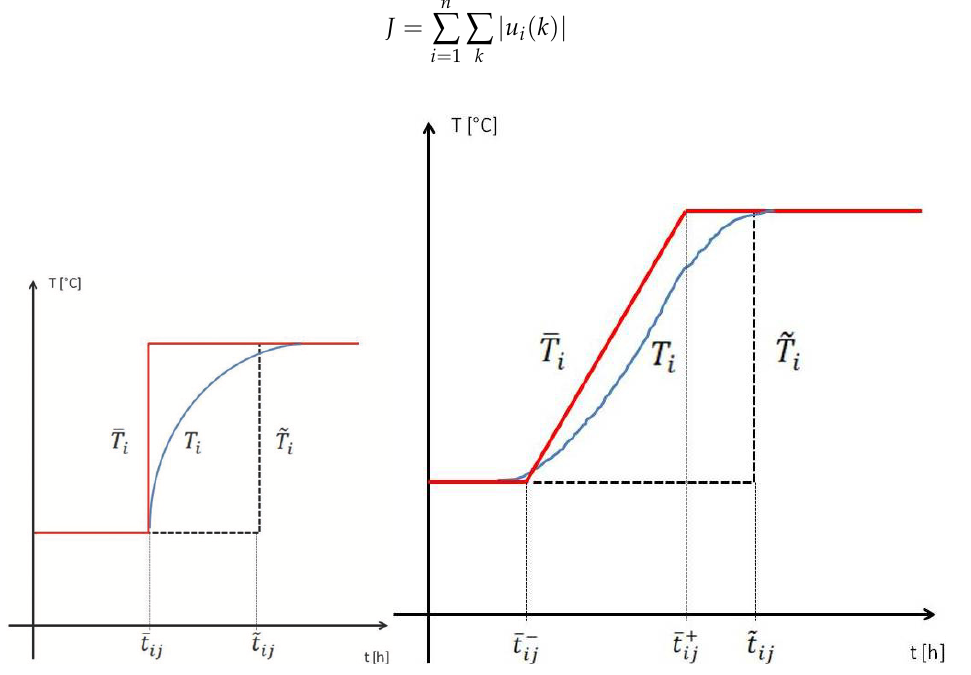
Figure 2. A sketch of the use of optimized step and ramp signals